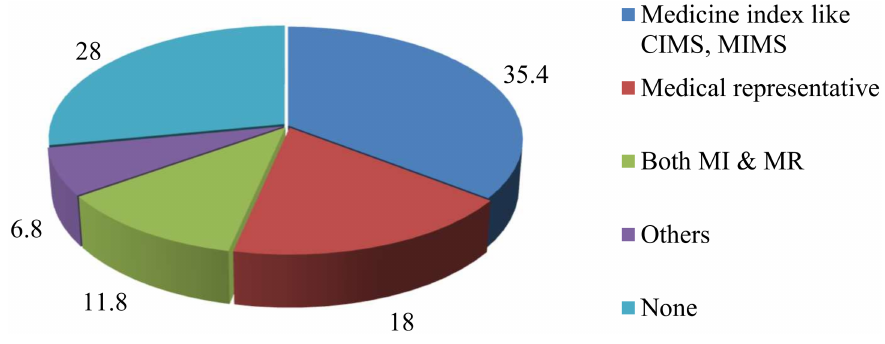
Fig 1. Sources of medicine information for pharmacy staffs.